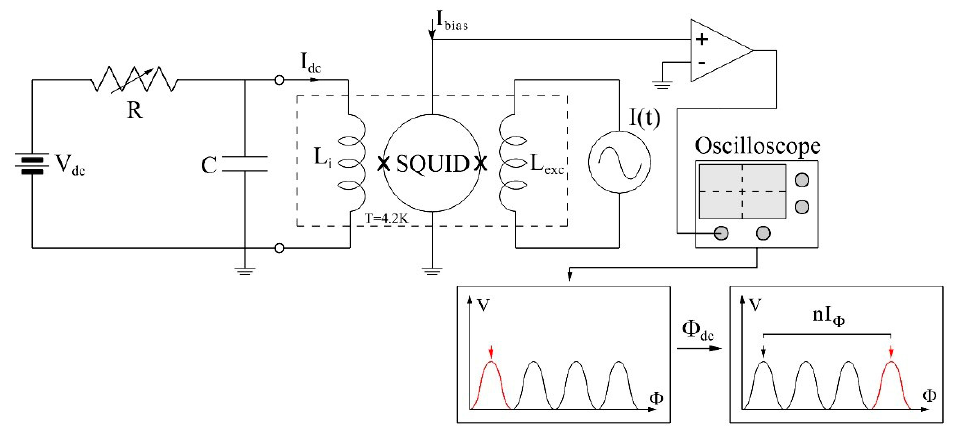
Figure 3. Measurement scheme for evaluation of the current − to − magnetic − flux transfer factor (I Φ ) of both SQUID sensors.